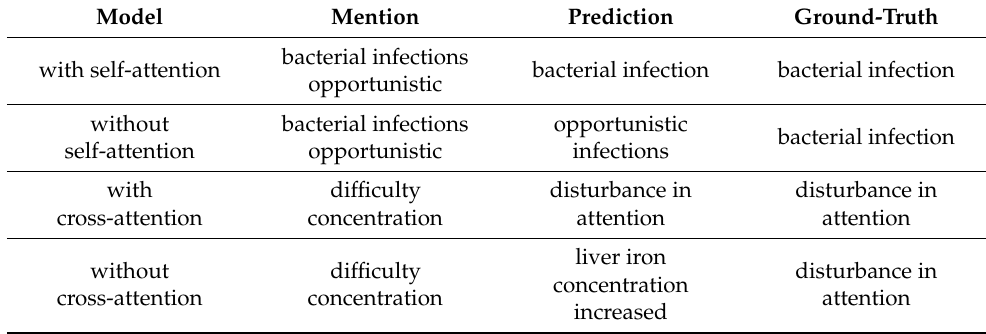
Table 8. Effect of inter- and intra-entity attention on prediction